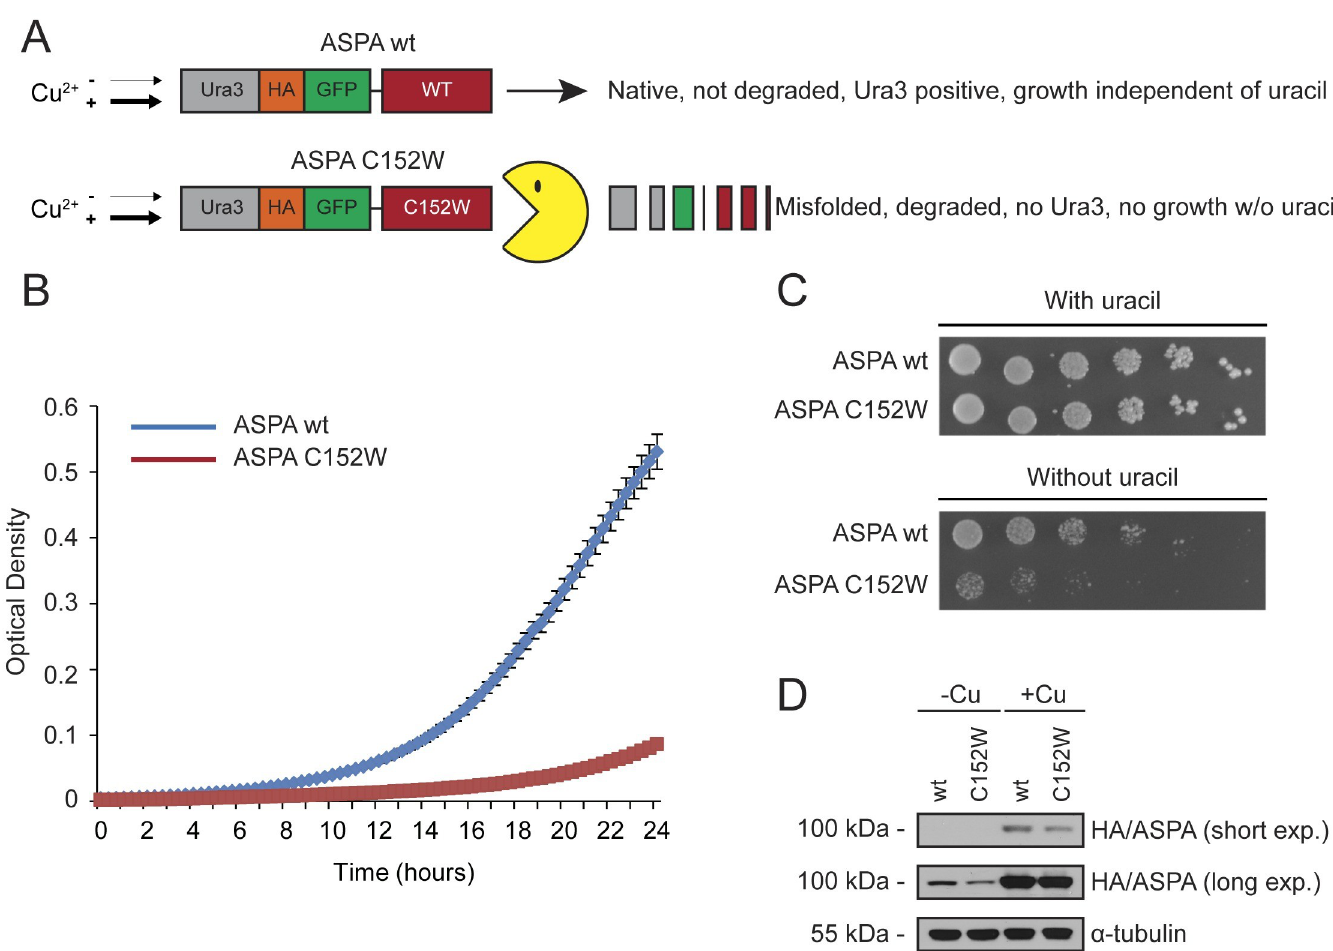
Fig 1. A growth-based yeast reporter system for protein abundance. (A) Illustration of the reporter system coupling ASPA steady-state levels to yeast growth. Wild- type ASPA and the C152W variant are expressed from the CUP1 promoter with an N-terminal fusion construct consisting of Ura3-HA-GFP. When yeast cells express these constructs, their growth in medium lacking uracil depends on the level of the ASPA fusion protein. (B) The growth of wild-type yeast cells expressing the indicated ASPA fusion protein in liquid medium lacking uracil. The optical density was measured at 600 nm. Error bars represent the standard deviation (n = 4). (C) Wild-type yeast cells expressing the indicated ASPA construct grown on solid medium with or without uracil. (D) Western blot of ASPA protein levels in wild-type yeast expressing the indicated ASPA fusion construct. The ASPA fusion proteins are under the control of the CUP1 promoter, which was either uninduced (-Cu) or induced (+Cu) with copper as